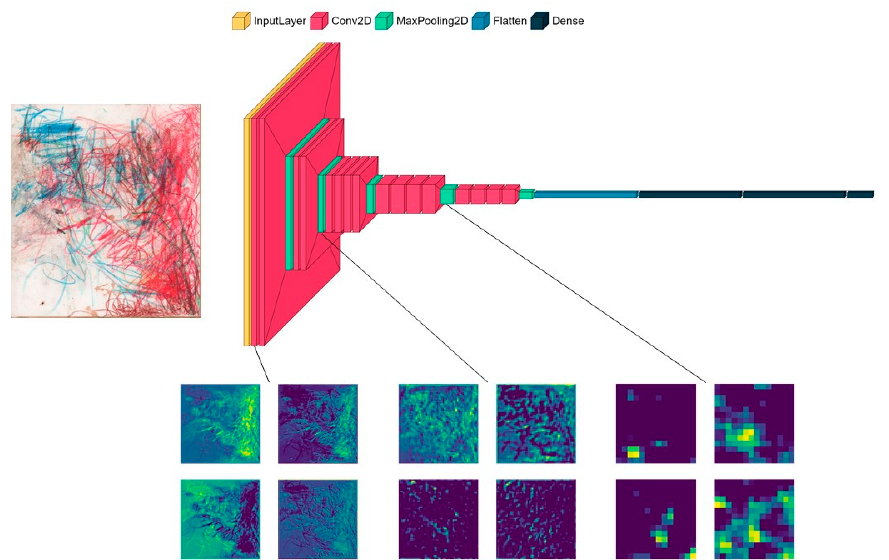
Figure 2. VGG19 model architecture and examples of feature maps (on the bottom) for a drawing. From left to right, each 2 × 2 square of feature maps are extracted from block1_conv1, block3_conv1, block5_conv1, respectively. The early blocks are in a high resolution, as the filters capture fine details, compared to deeper blocks, where the filters detect more general concepts.